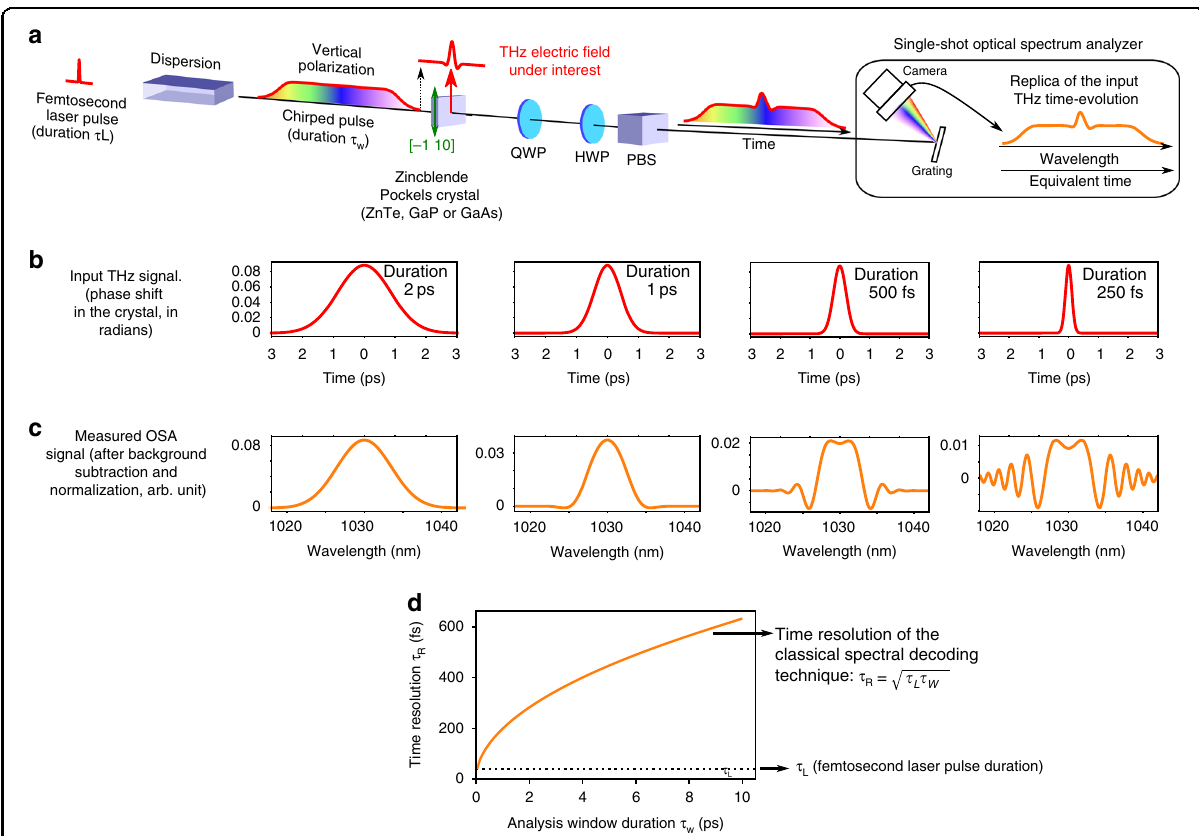
Fig. 1 Principle and limitations of classical single-shot THz waveform recorders using time-to-spectrum conversion (also known as spectral decoding). a Principle. The electric fi eld pulse shape modulates the birefringence of a Pockels electro-optic crystal. A probe chirped laser pulse (with stretched duration τ w ) is then intensity-modulated in single shot after passing the Pockels crystal, the quarter and half-wave plates (QWP and HWP) and the polarizing beam-splitter (PBS). Because of the laser chirp, the input temporal shape is expected to be “ replicated ” in the laser spectrum recorded by the grating OSA. b , c Fundamental time-resolution limitation of the method (numerical simulation assuming a perfect crystal with in fi nite bandwidth). The method is unreliable (i.e., strong deformations occur) when the input THz pulse is shorter than τ R = 0.7 ps, although a 39 fs femtosecond laser is used. d Resolution limitation of the classical method (orange, from Eq. 1). An objective of DEOS is to remove this limitation, and obtain a resolution that does no more degrades when the duration of the analysis window τ w is increased. The probe laser compressed duration τ L (black line) is given for reference. Laser parameters: 1030 nm wavelength and 40 nm FWHM bandwidth (i.e., τ L = 39 fs compressed laser pulse duration). τ w = 10 ps FWHM. See Table 1 for crystal orientations, and “ Materials and methods ” for